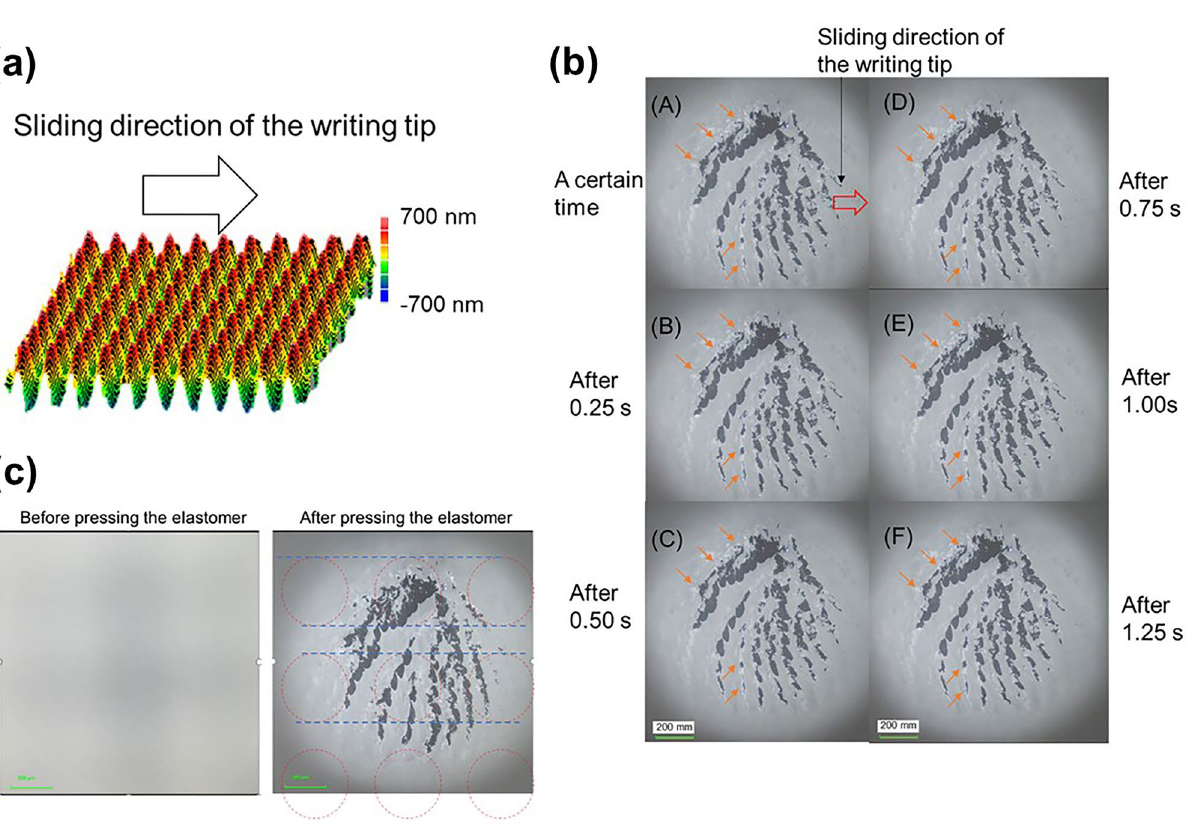
Figure 7. ( a ) Lattice-shaped pattern with 500 μm spacing and 560 nm of the height and sliding direction of the writing tips. ( b ) Observations of contact area between the elastomer and lattice-shaped patterned glass surfaces during sliding motion (pitch: 500 μm, height: 560 nm). ( c ) Observation of the contact part before and after pressing the elastomer onto lattice-shaped patterned glass surface (pitch: 500 μm, height: 560 nm). The lattice- shaped pattern can be observed before pressing the elastomer onto the glass